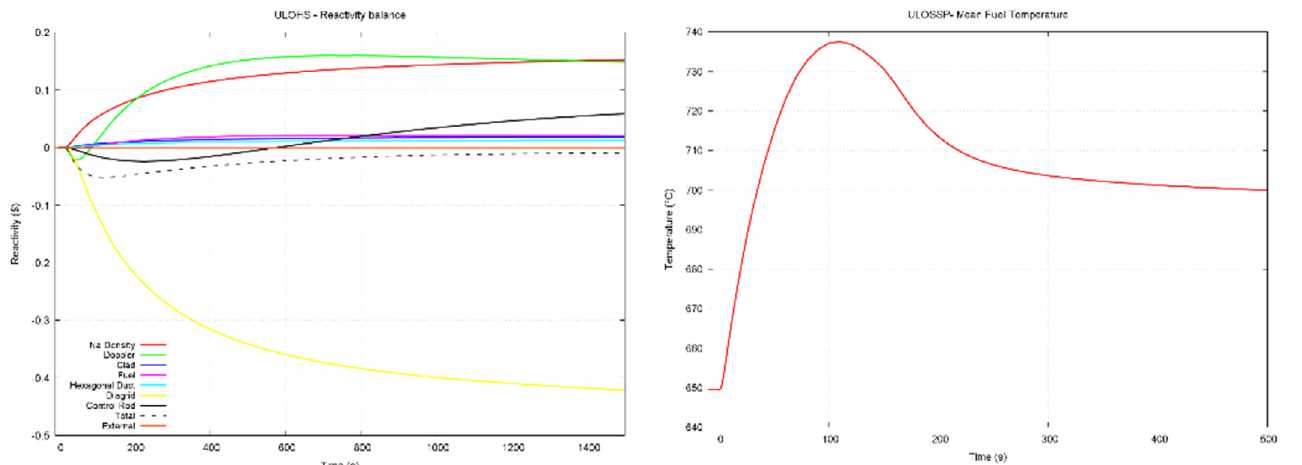
Fig. 14. Mean fuel temperature.